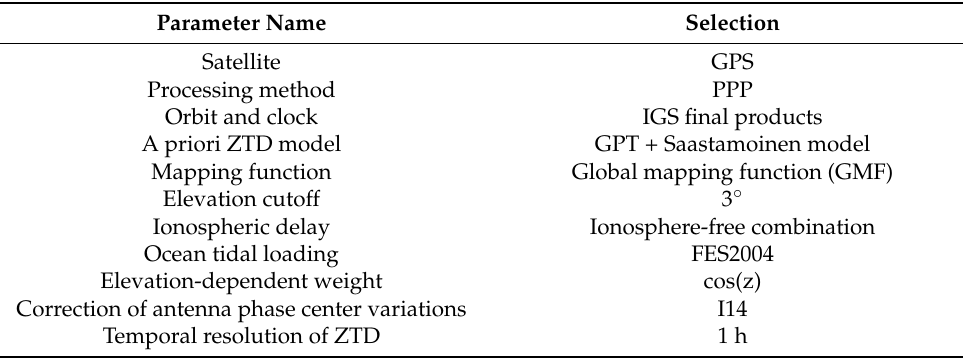
Table 1. Strategies adopted for GNSS data